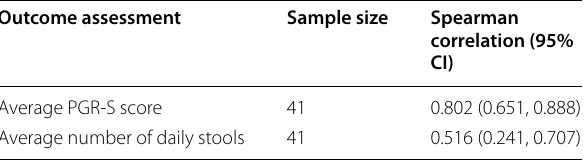
CI confidence interval, NRS numeric rating scale, PGR-S patient global rating of